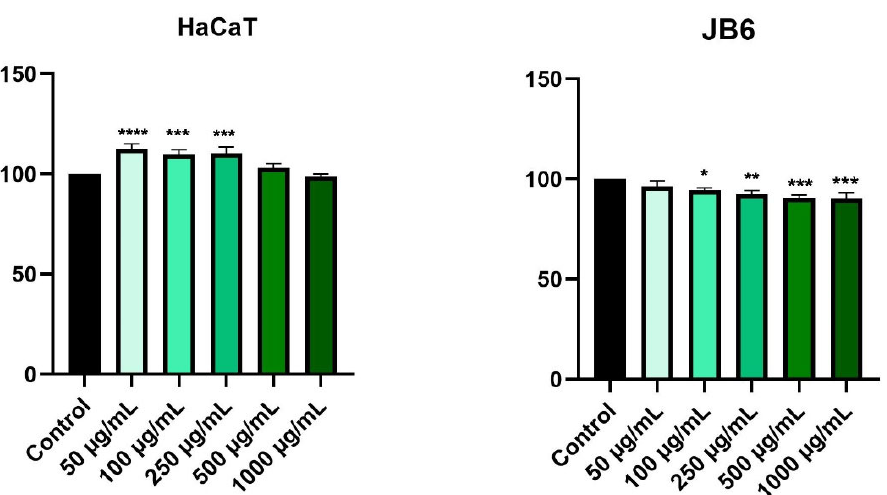
Figure 2. In vitro evaluation of the effect of HPex (50, 100, 250, 500, and 1000 µ g/mL) on cell viability on HaCaT and JB6, after 24 h of treatment. The results are presented as cell viability percentage (%) normalized to control (unstimulated) cells and are expressed as mean values ± SD of three independent experiments performed in triplicate. For statistical analysis and comparison between the control and the treated group, one-way ANOVA analysis was applied, followed by Dunnett’s multiple post-test comparisons (* p < 0.1, ** p <0.01, *** p <0.001, and **** p <0.0001). To determine the in vitro cytotoxicity effect, four tumor cell lines were chosen: MCF-7, MDA-MB-231, B164A5 and A43, at which the five concentrations previously tested on healthy cell lines were